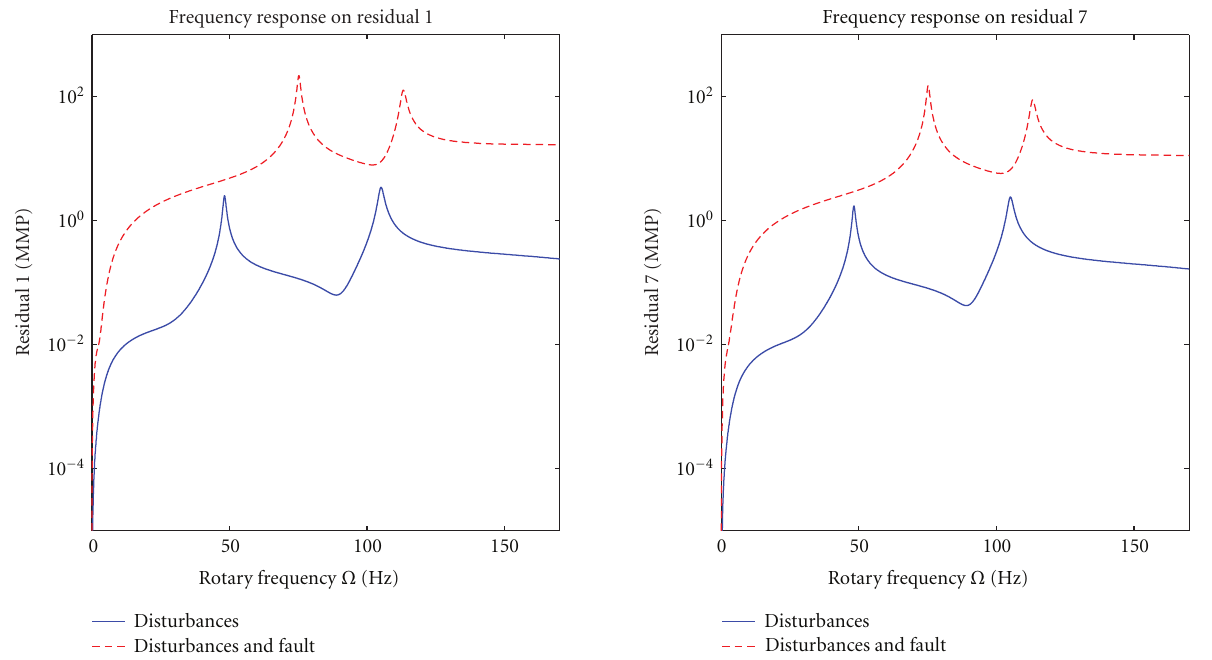
Figure 8: Frequency response of disturbances and fault on the residuals generated by the observer designed by model matching.